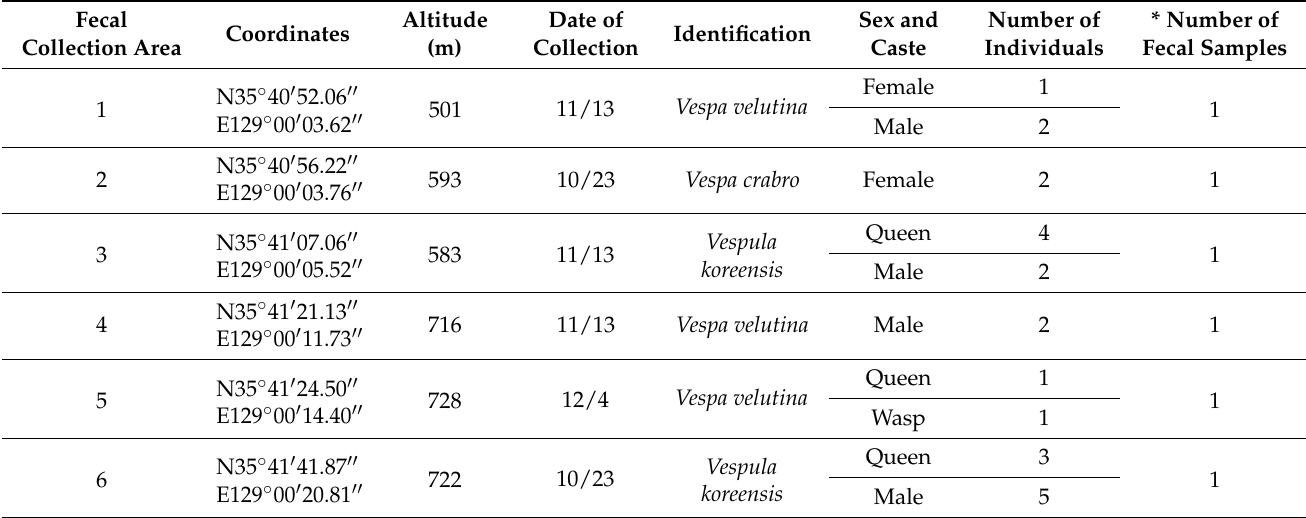
Table 1. Location information for the yellow-throated marten (YTM) fecal samples containing wasp debris and the identified species, caste, and number of individuals between October and December 2019.